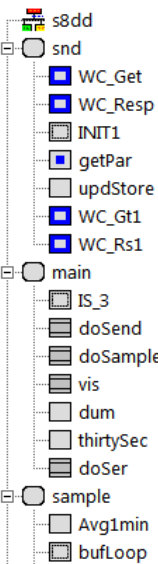
Figure 14. Model tree view, showing the order of evaluation of Steps and variable tracing.